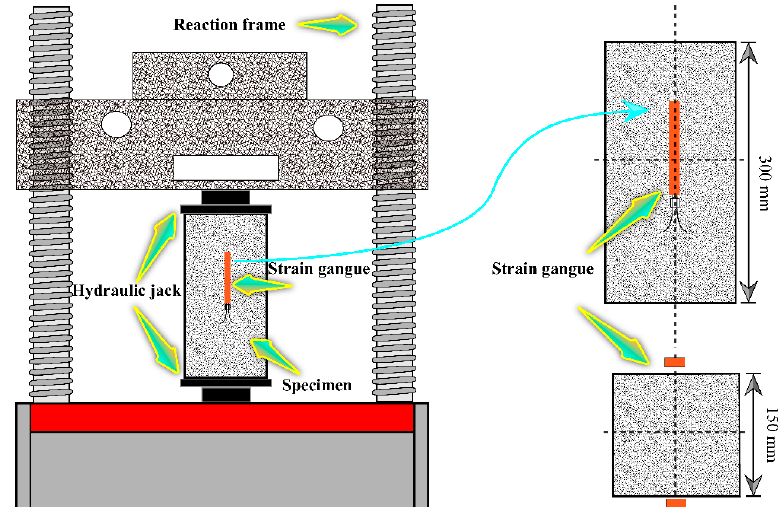
Figure 3. Test machine and arrangement method.